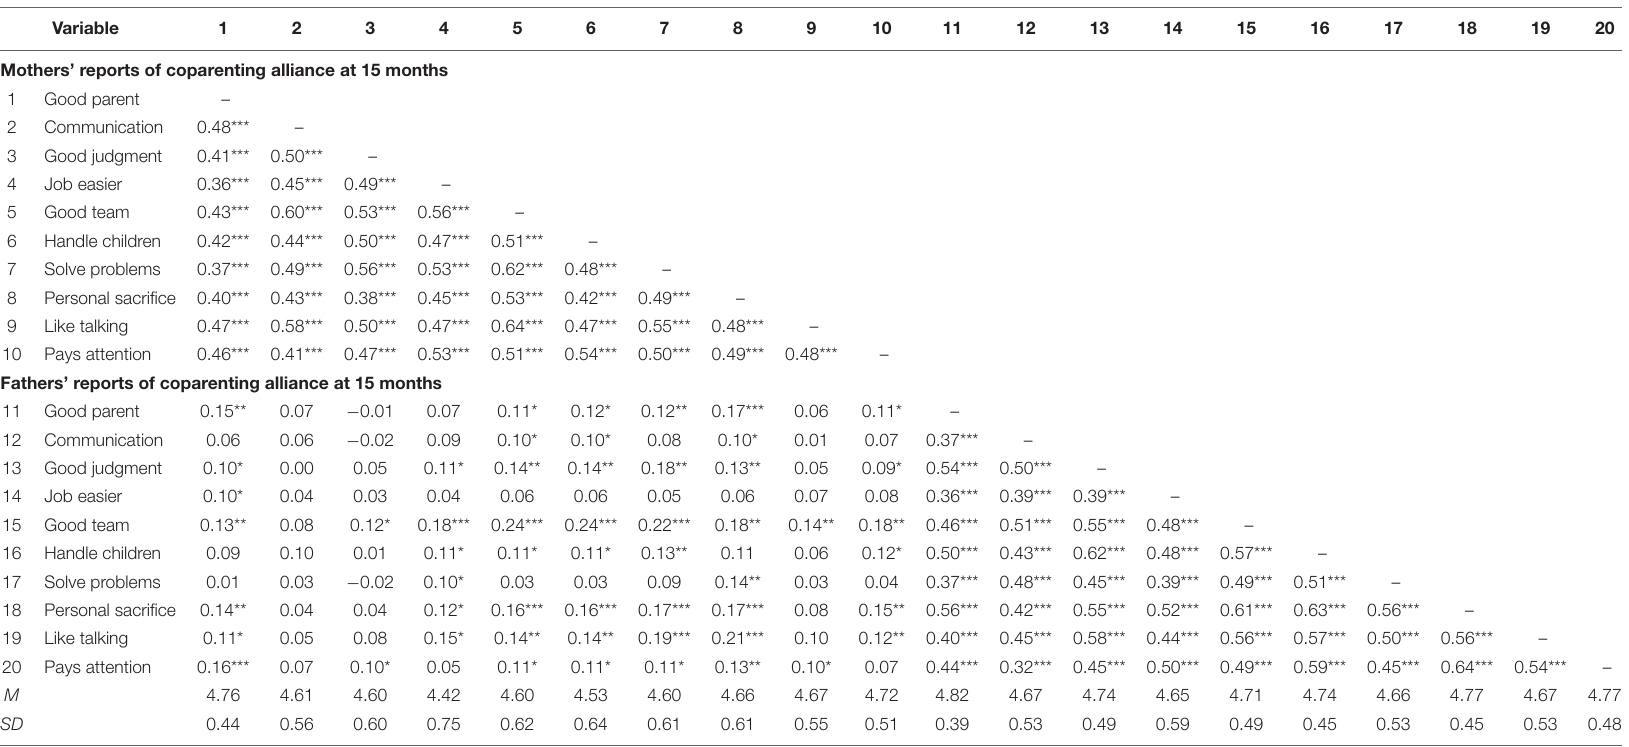
TABLE 2 | Descriptive statistics and correlations of mothers’ and fathers’ coparenting alliance and responsive parenting indicators and latent variables.